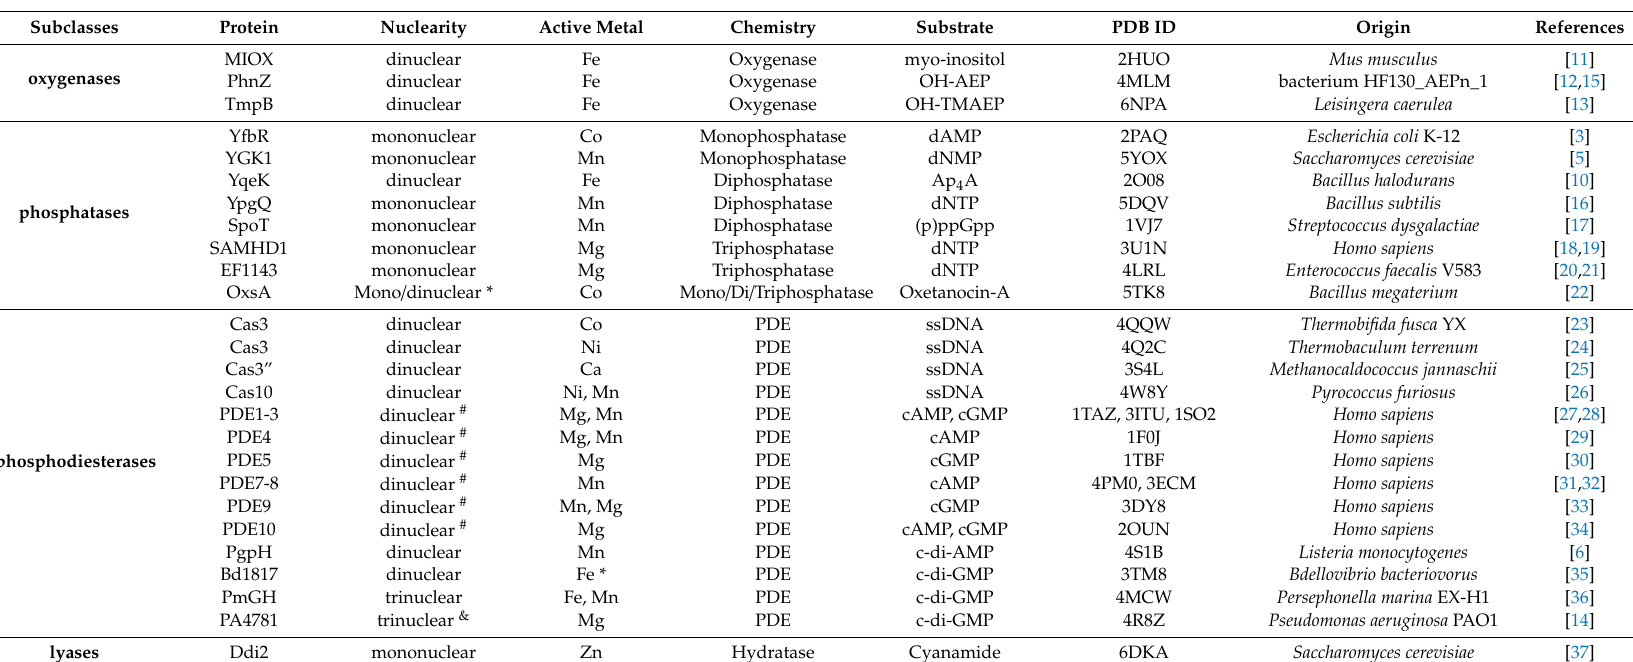
Table 1. List of representative histidine–aspartate (HD)-domain proteins from the three known subclasses, oxygenases, phosphatases and phosphodiesterases (PDEs), that are crystallographically and biochemically